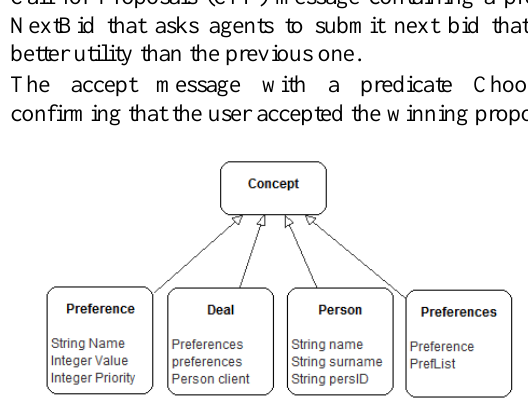
Fig. 4. Concepts defined during the interaction design.